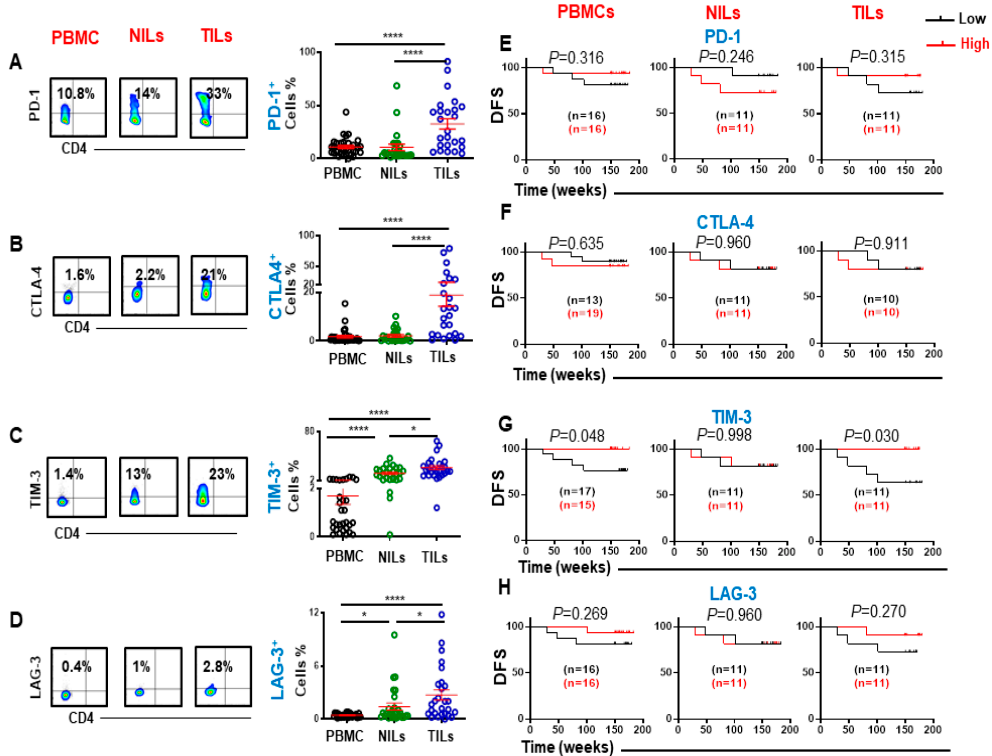
Figure 2. Flow cytometric plots, scatter plots, and Kaplan–Meier survival curves for DFS based on the levels of PD-1, CTLA-4, TIM-3, and LAG-3-expressing CD3 + CD4 − T cells. Representative flow cytometric and scatter plots present the levels of PD-1( A ), CTLA-4 ( B ), TIM-3 ( C ), and LAG-3 ( D ) expressing CD8 + T cells in PBMCs, NILs, and TILs. CRC patients with high levels of PD-1 ( E ), CTLA-4 ( F ) , TIM-3 ( G ), and LAG-3 ( H )-expressing cells were compared with patients with low levels of these cells to determine DFS. The number of patients included in each comparison are specified on each survival curve. Statistical analysis are shown with significance levels indicated at * p < 0.05 and **** p < 0.0001.